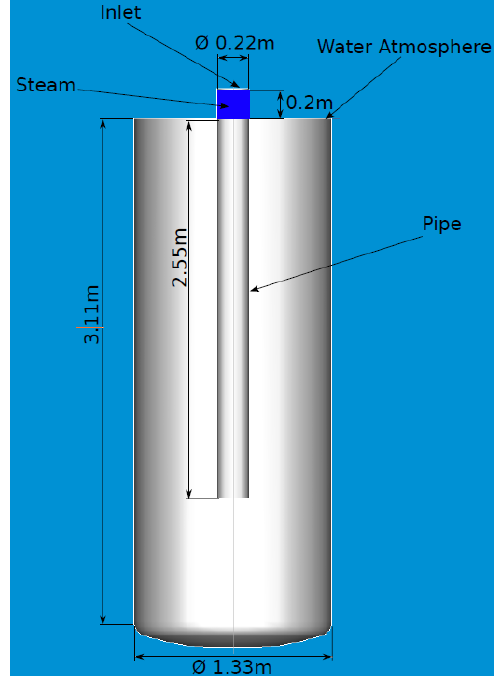
Figure 8. The model used for simulation [75].